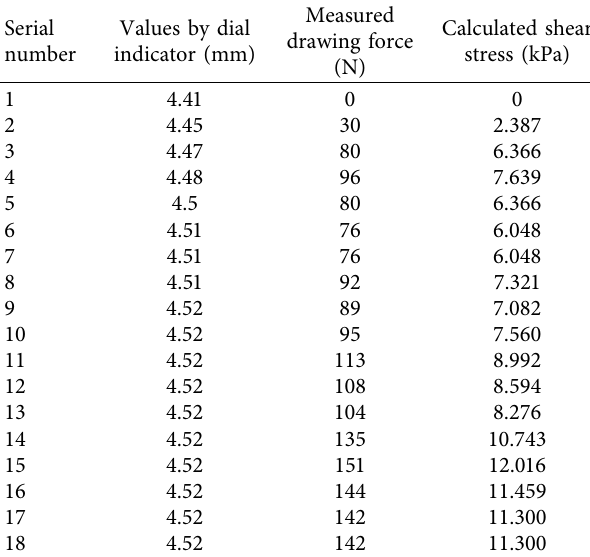
Table 3: The measured test values and calculated value of shear stress (the third test).